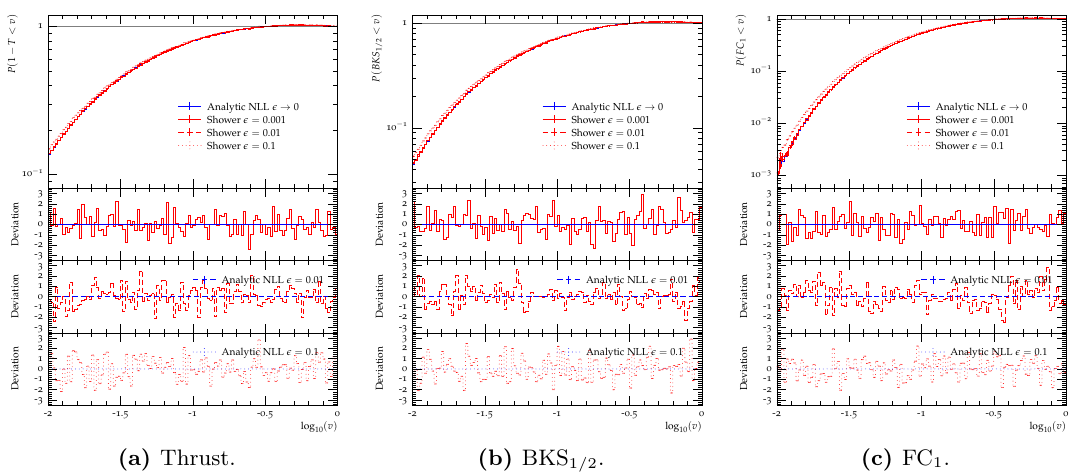
Figure 1 . Thrust variable 1 T (a), BKS observable with x = 1 = 2 (b) and fractional energy (cid:0) correlation with x = 1 (c) for di(cid:11)erent values of the cuto(cid:11) (cid:15) in eq. (2.14). The respective analytic results for ( v ) are used as a reference in the ratio F (cid:15)